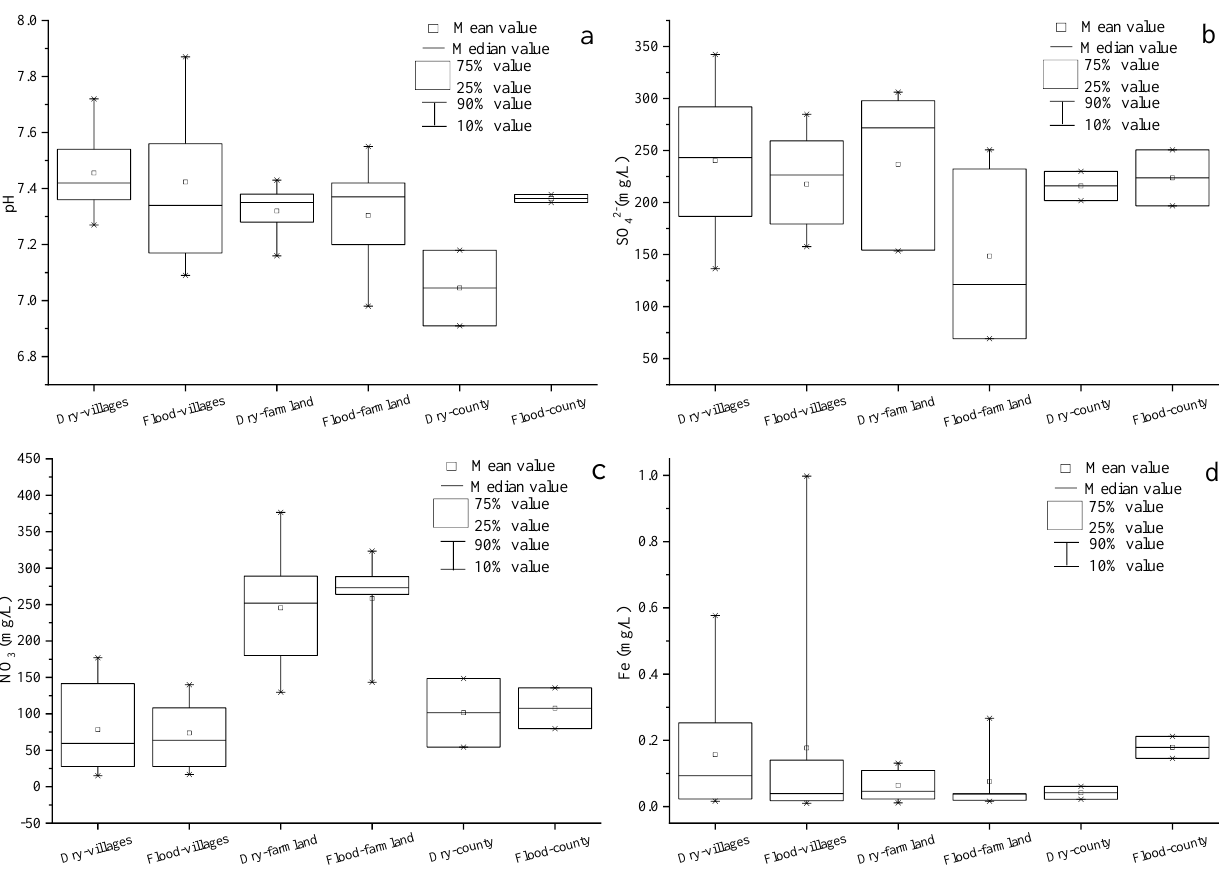
Figure 3. Spatial – temporal variations of ( a ) pH; ( b ) SO 42- ; ( c ) NO 3- , and ( d ) Fe in groundwater of the Figure 3. Spatial–temporal variations of ( a ) pH; ( b ) SO 42 − ; ( c ) NO 3 − , and ( d ) Fe in groundwater of Ye River area(The number of samples in Figure 3 (a, b, c and d) are all 32). the Ye River area (The number of samples in Figure 3a–d are all